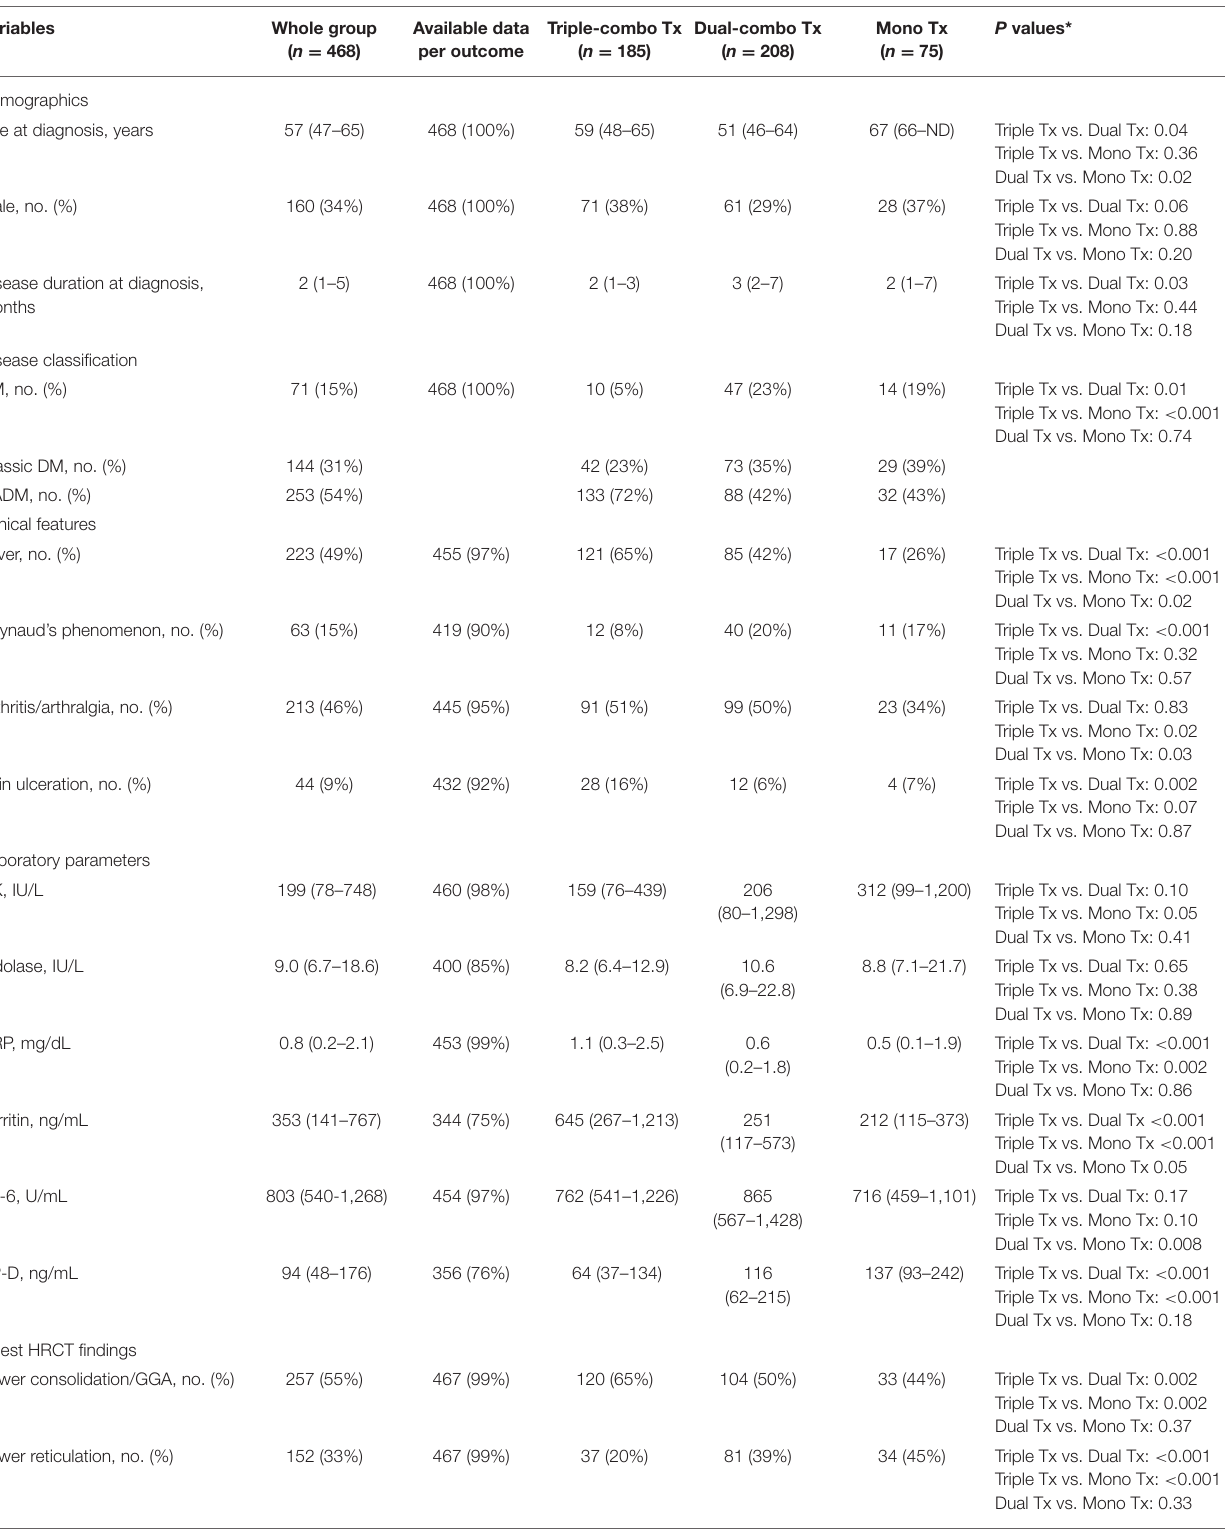
TABLE 1 | Baseline characteristics of patients with myositis-ILD stratified by therapeutic regimen.